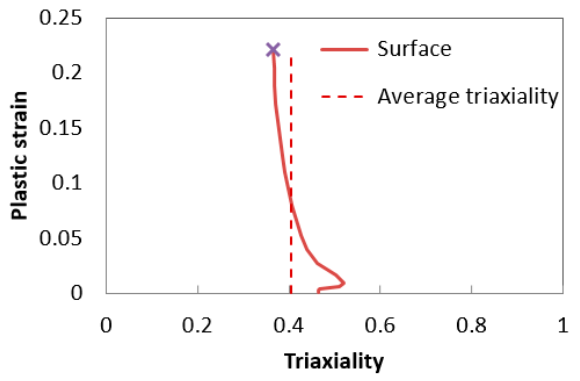
Figure 24. Triaxiality path for notched tensile test.